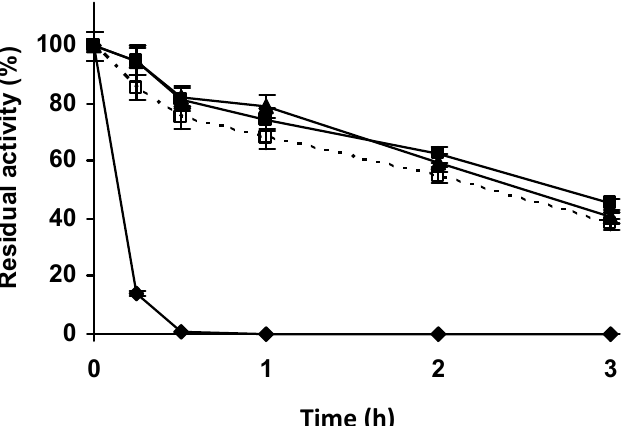
Figure 11. Thermal inactivation of r Aae UPO biocatalysts immobilized on MANAE agarose support at different pH. The experiment was performed in 10 mM Tris at 57 ◦ C and pH 7.0. Other specifications can be found in the Methods section. Full triangles: MANAE biocatalyst prepared at pH 5.0; full squares: MANAE biocatalyst prepared at pH 7.0; full rhombus: MANAE biocatalyst prepared at pH 9.0; empty squares with dotted line: free enzyme.